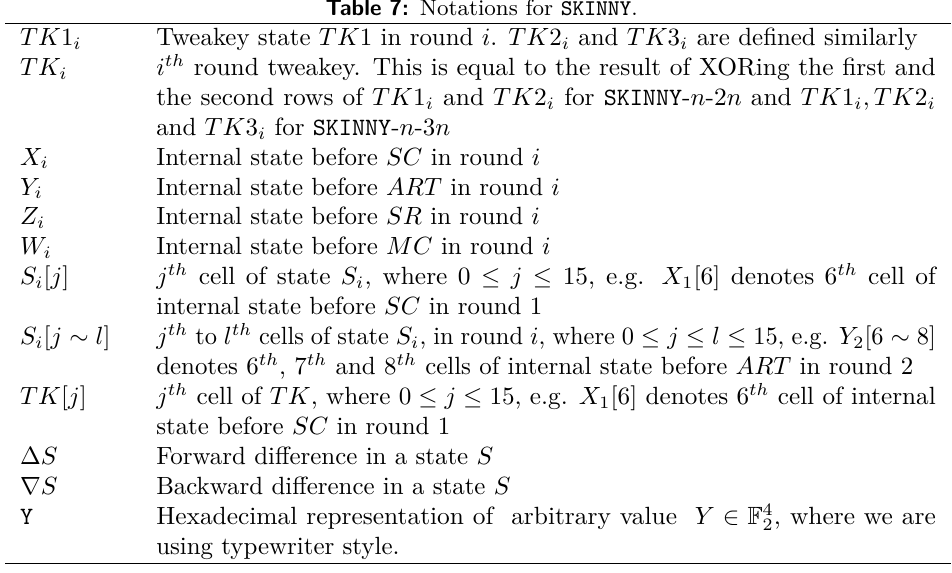
Table 7: Notations for SKINNY